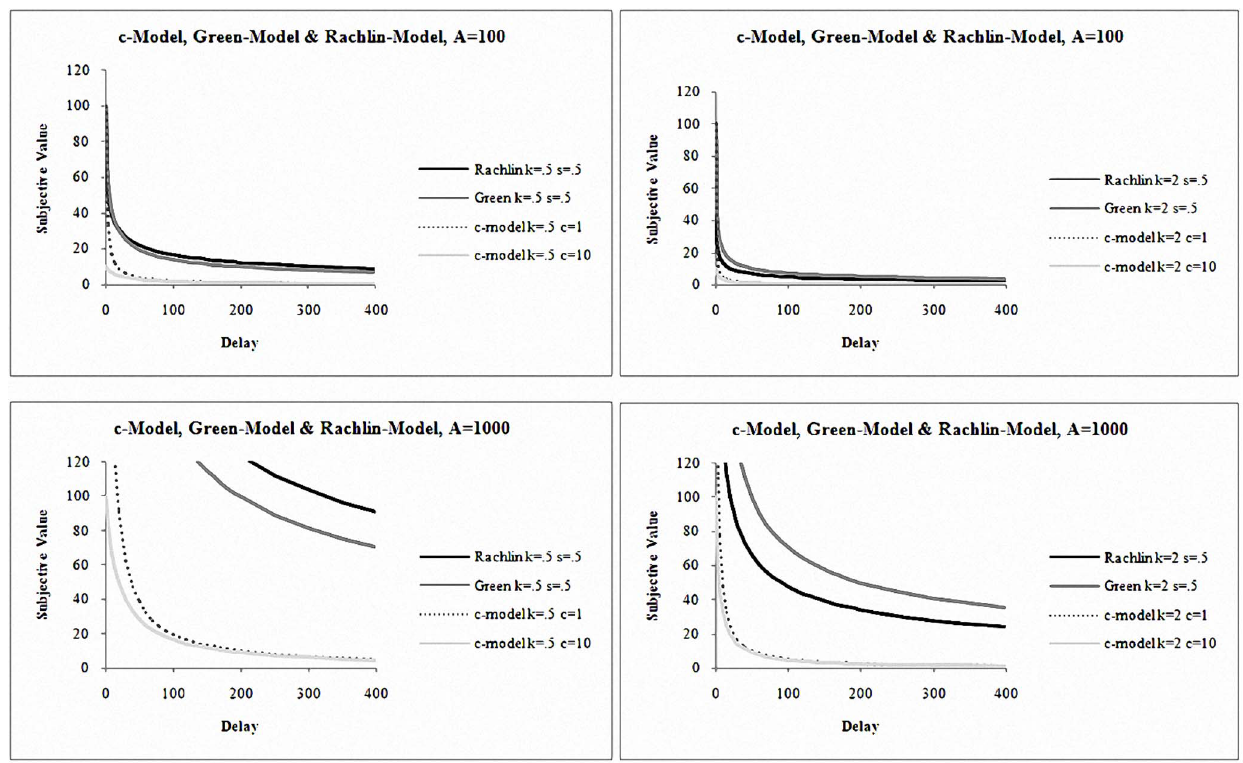
Figure 1. Subjective Value of A from c -, Rachlin- with parameters k =0.5 and 2; c =1 and 10; s =0.5. A=100 and 1000.